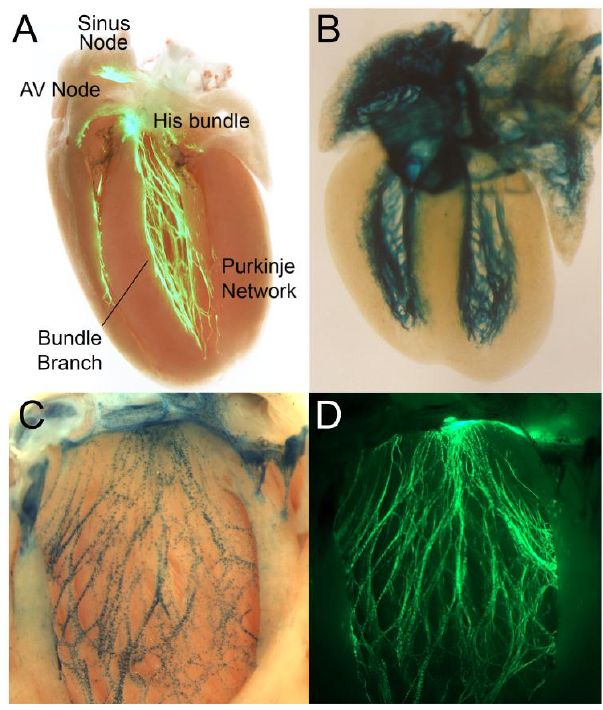
Figure 1. Cardiac conduction system (CCS) reporter mice. ( A ) Contactin2-eGFP demonstrating CCS components (Reproduced with permission from [1]); ( B ) cardiac conduction system reporter-LacZ in an embryonic day 17.5 heart (Reproduced with permission from [2]); ( C , D ) co-expression of